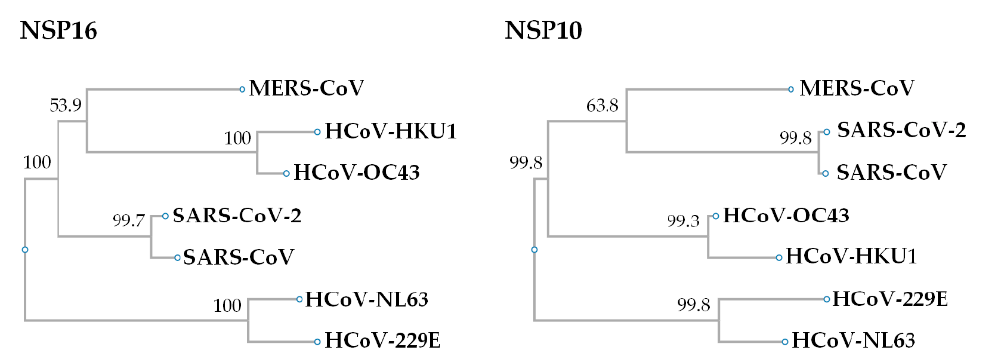
Figure 2. Phylogenetic analysis of the NSP16/NSP10 amino acid sequences of severe acute respiratory syndrome coronavirus 2 (SARS-CoV-2) with other human coronaviruses. The phylogenetic relationship of SARS-CoV-2 NSP16 and NSP10 to other human coronaviruses was constructed by the ETE3 method of CLUSTALW software. The bootstrap values are shown as percentages at the nodes. Human coronaviruses NCBI Reference Sequence Database (RefSeq) sequences from GenBank